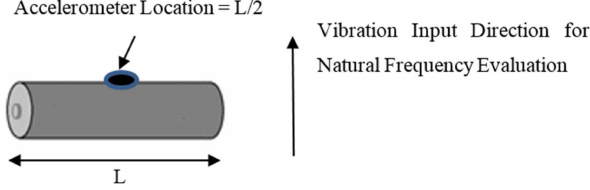
Figure 7. Location of cell accelerometer for natural frequency measurement via swept sine frequency sweep.